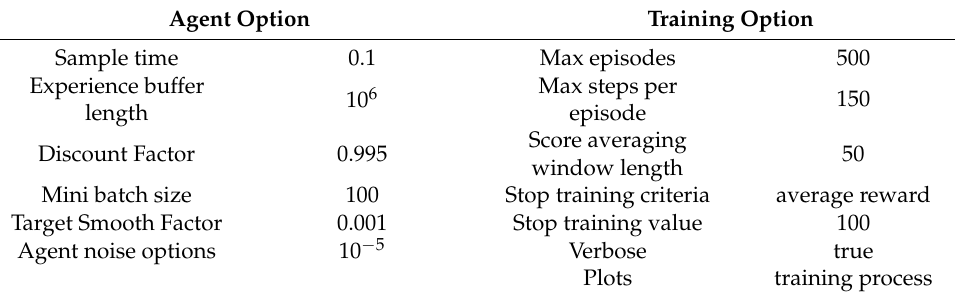
Table 4. The options for the agent and training.